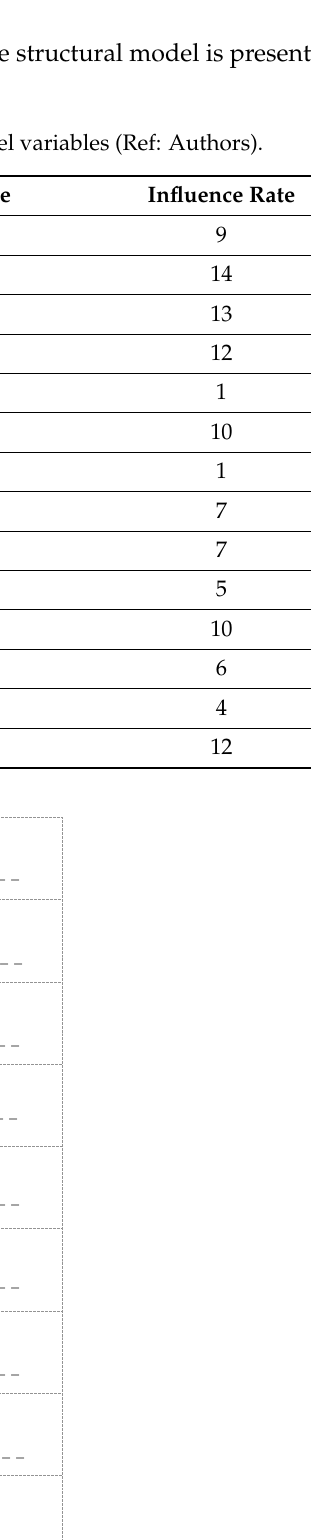
Table 8. Final received matrix (Ref: Authors).